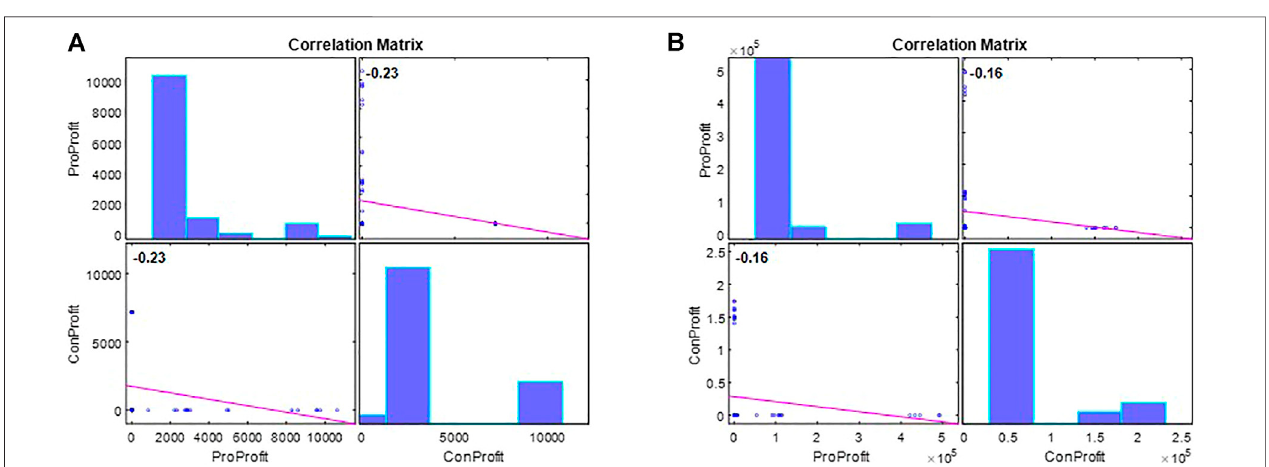
FIGURE 10 | Correlation coef fi cient of the (A) original method and (B) proposed method in 69 buses scenario.